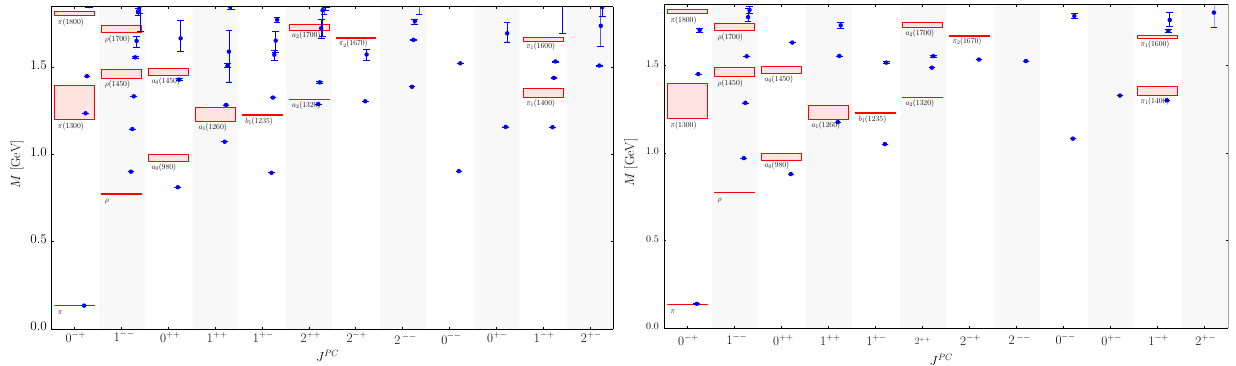
Fig. 4 χ 2 plot from the comparison of our calculated and the experimental splitting sets as a function of ω and D . Left panel combination of all listed splittings together; center panel: combination of all sets of selected splittings together; right panel combination of all listed reduced selections (see text)